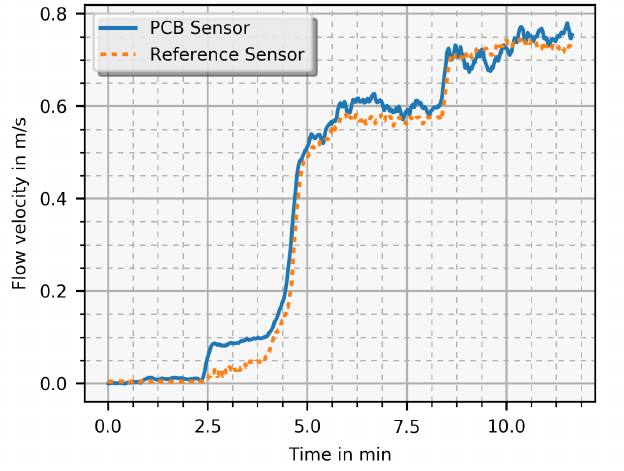
Figure 11. Start-up detail (timely zoomed in) of a measurement (similar to Figure 10). The PCB sensor recognises small flow velocities (at 2.5min) before the reference does. Both sensors need the same settling time before an accurate value is achieved. Detailed information about the response property can be found